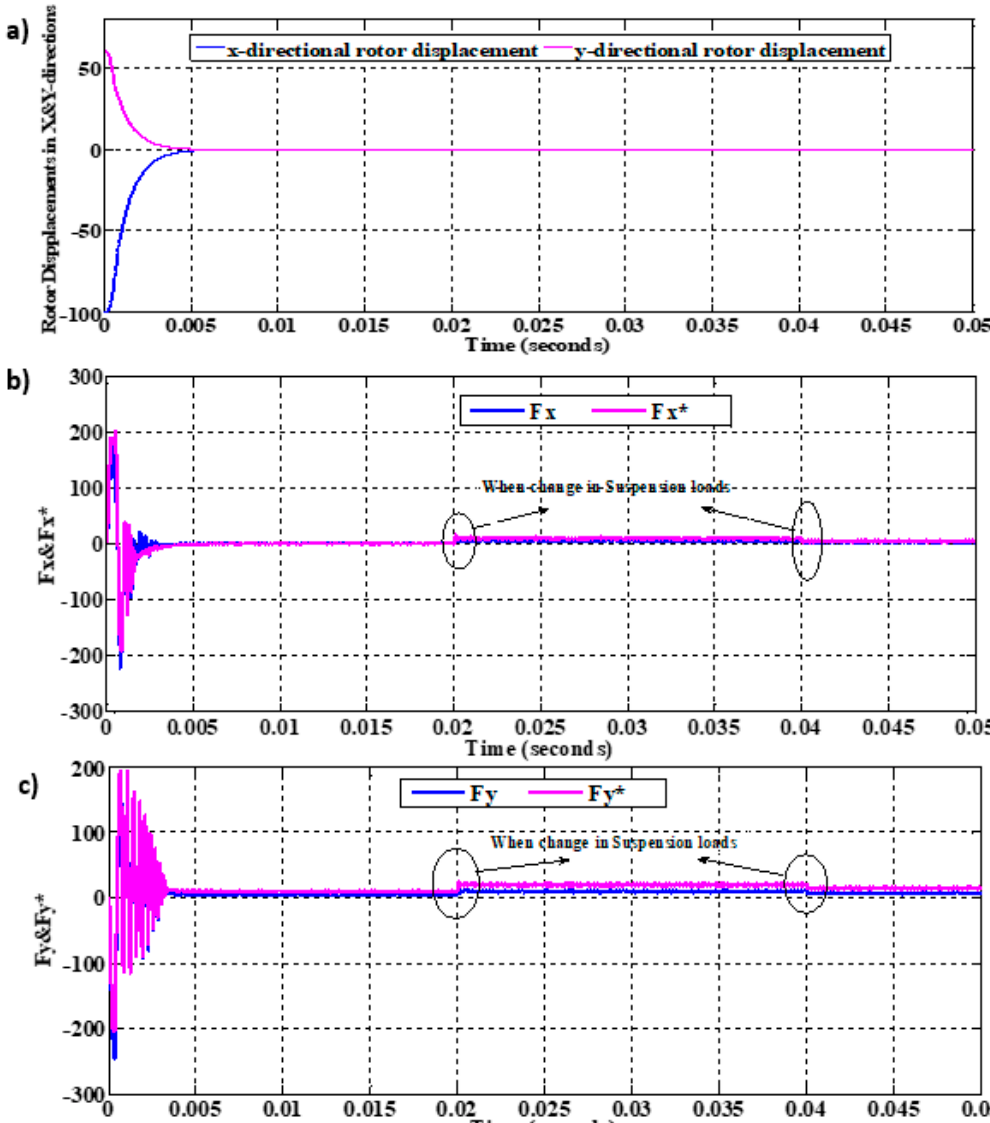
Figure 16. ( a ) Rotor X and Y displacements, ( b ) actual and estimated X-directional suspension forces when suspension loads are applied, and ( c ) actual and estimated Y-directional suspension forces when suspension loads are applied.